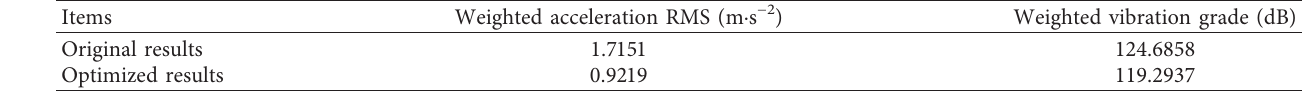
Table 4: Evaluation of ride comfort.